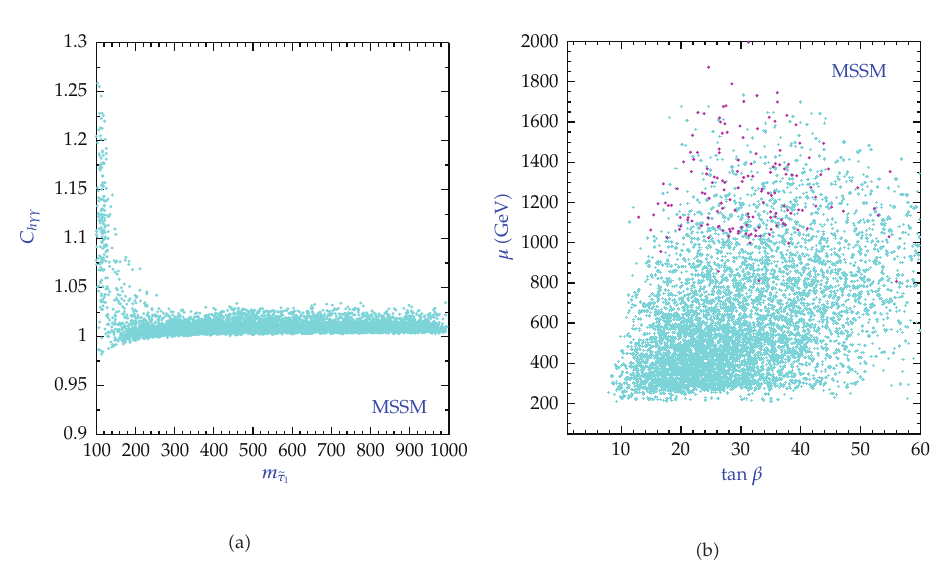
and the reduced 1